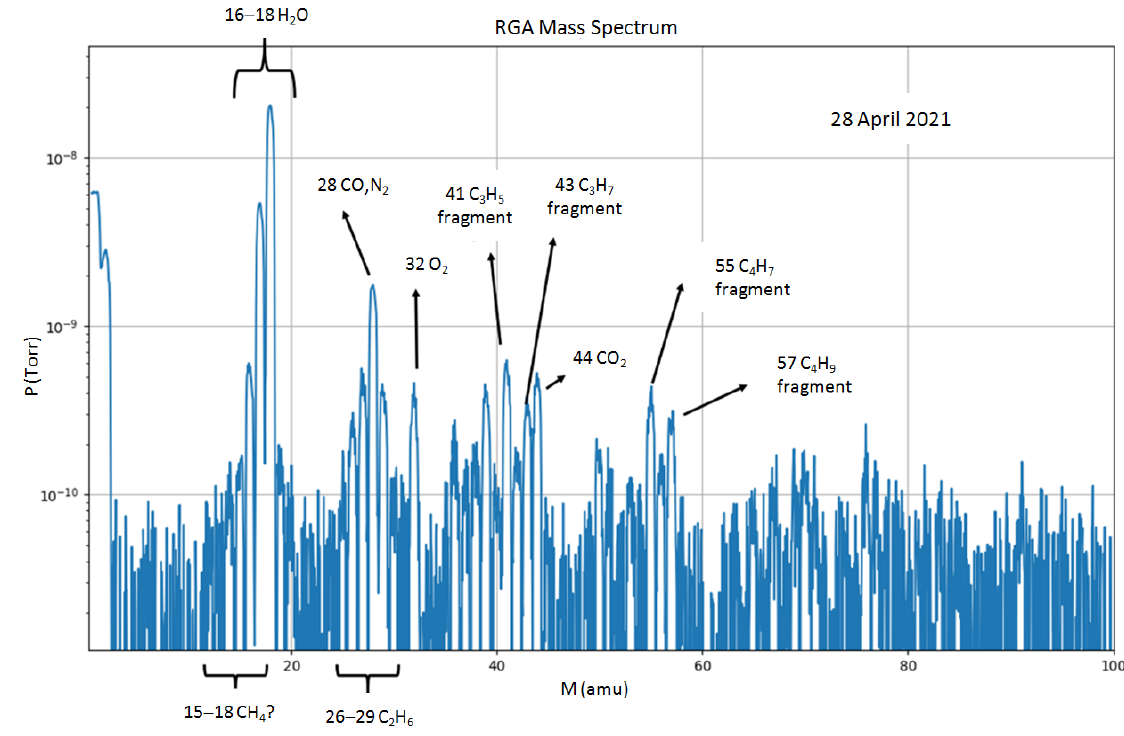
Figure 13. Identification of the peaks in the DiFU chamber residual gas spectrum.